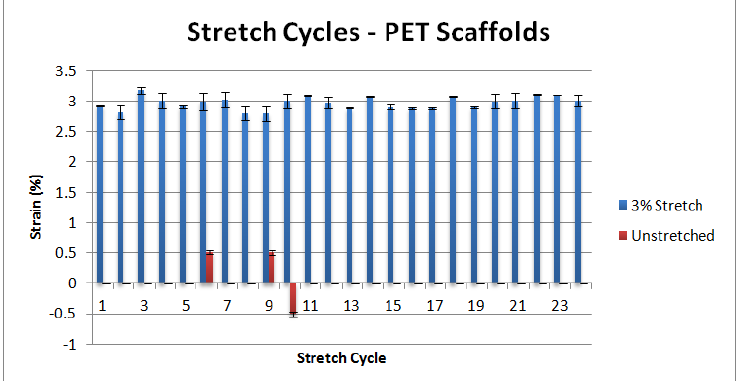
Figure 6. Stretch cycles of the PET scaffolds in the bioreactor. Each bar represents the average strain across all four scaffolds for that stretch cycle. Error bars represent one standard deviation. n =